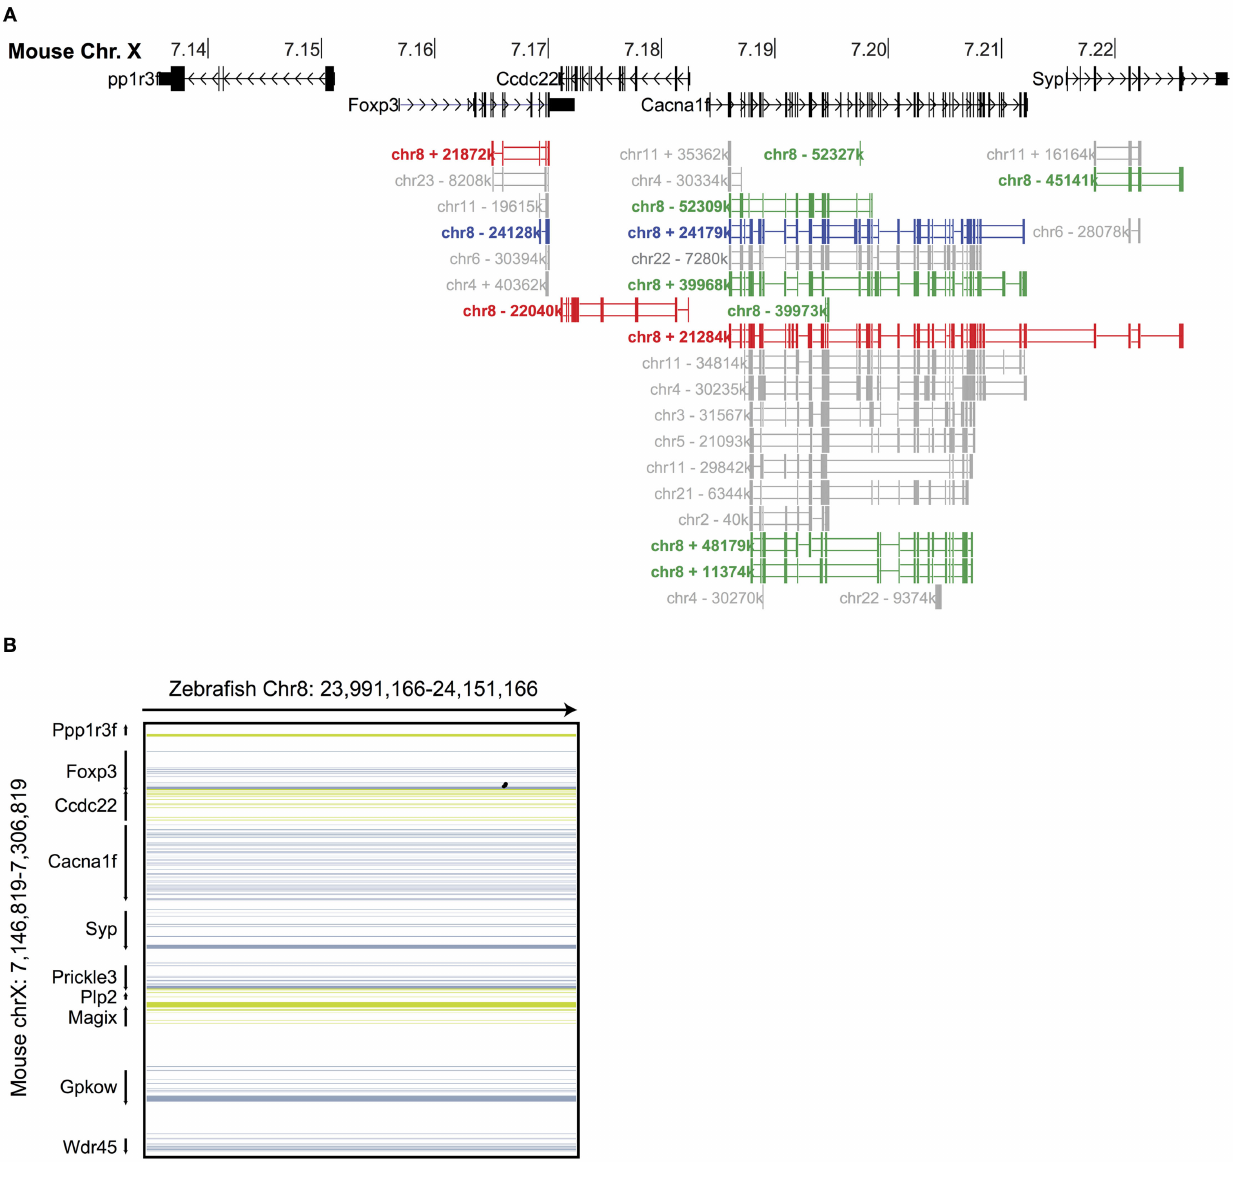
around 21.8mb), blue (Chr. 8 in the region around 24.1mb) and green (multiple regions on Chr. 8), and those from other chromosomes in gray. (B) Continuous genome alignments of 160kb flanking the murine foxp3 locus with the putative foxp3 locus from zebrafish on Chr. 8 in the region of 24.1mb (black dots: aligned region; dark blue/green: forward/reverse exons; light blue/green: forward/reverse